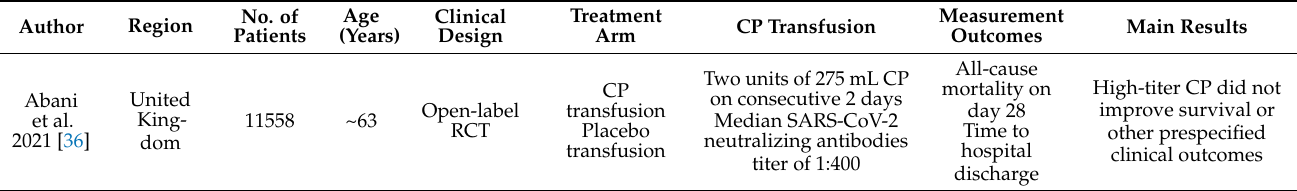
Figure 1. Systematic screening stages of literature review. Table 1. Summary of the characteristics of included